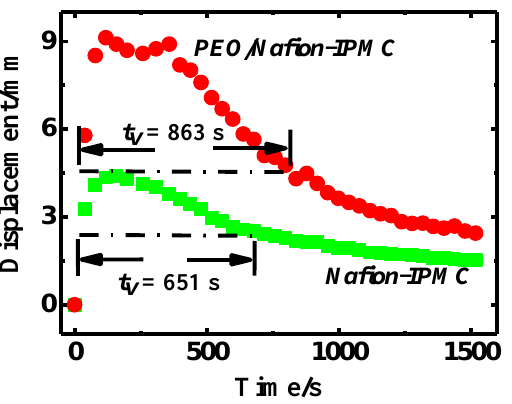
Figure 8. Displacement attenuation curves of IPMCs with 20 wt% PEO and pure Nafion.